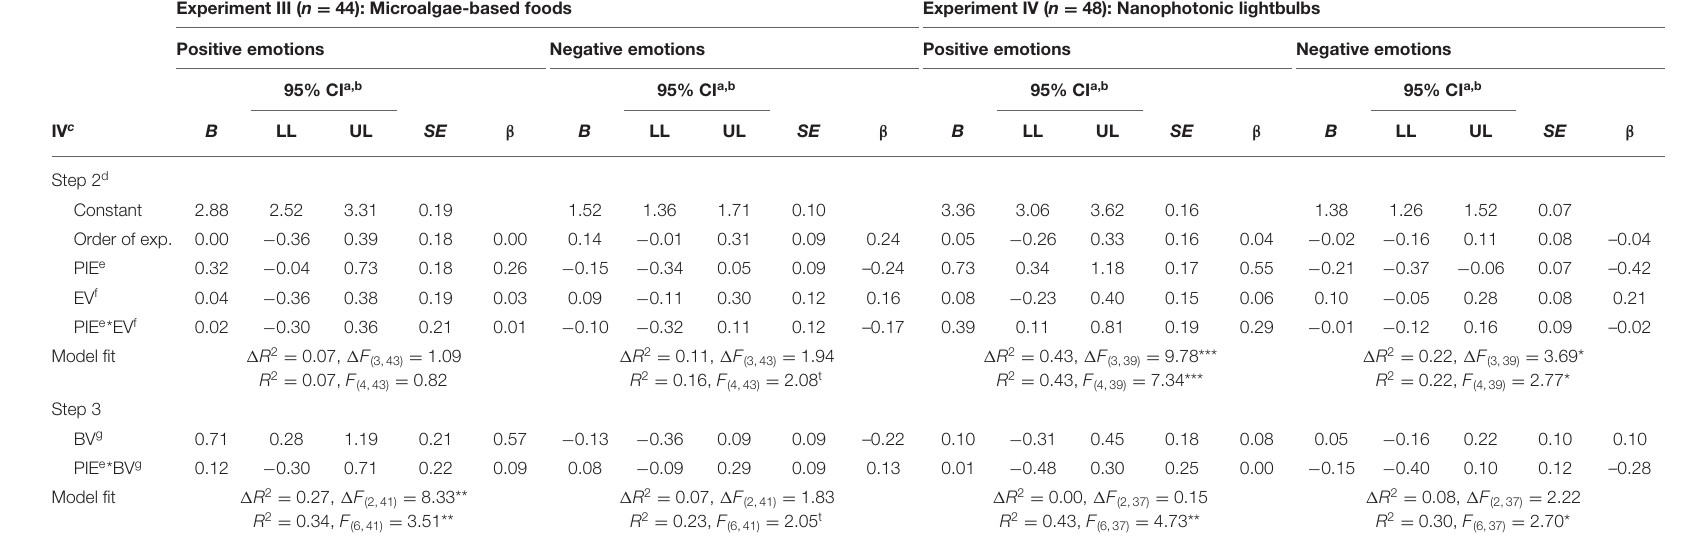
TABLE 4 | Regression coefficients of innovations’ perceived inexpensiveness, values, and their interactions on positive and negative emotions toward the innovations. Experiment III ( n = 44): Microalgae-based foods Experiment IV ( n = 48): Nanophotonic